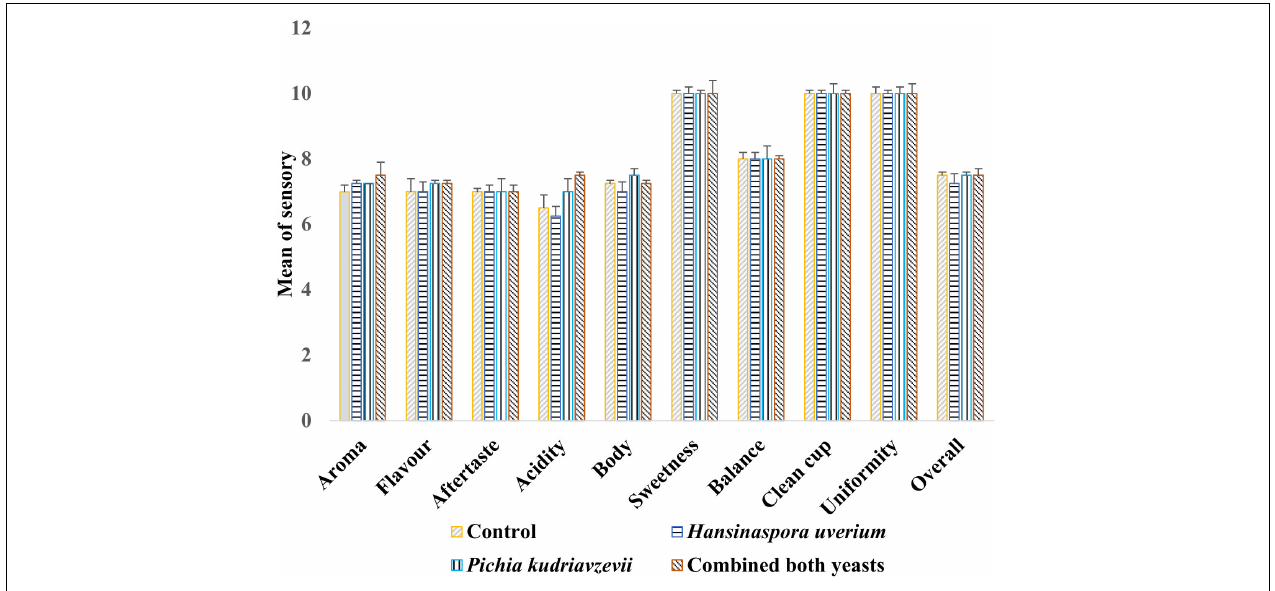
FIGURE 2 | Scores of cup test means (SCAA) by three Q-Graded coffee panelists for coffee beverages produced with roasted beans from the three inoculated ( H. uvarum, P. kudriavzevii , combined yeasts) and spontaneous (control) fermentations (Mean ± standard deviation).